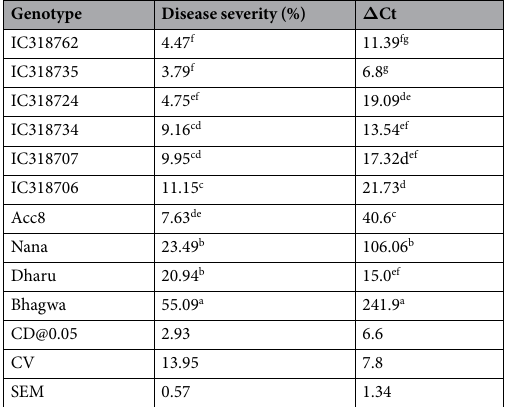
Table 2. Comparison between phenotype based disease severity and qPCR diagnosis of Xanthomonas axonopodis pv. Punicae . Δ Ct: Values derived from qPCR analysis using DNA extracted from Xap infected leaves, CV: coefficient of variation, CD: critical difference, SEM: standard error of the mean. Means followed by same letter between groups in a column are not significant at a confidence interval of 5%.